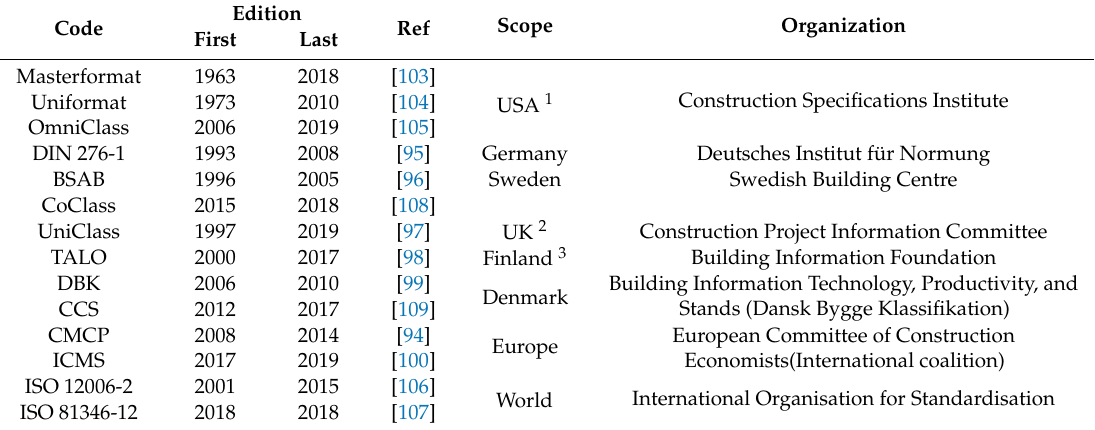
Table 5. Evolution of the main coding systems in the construction